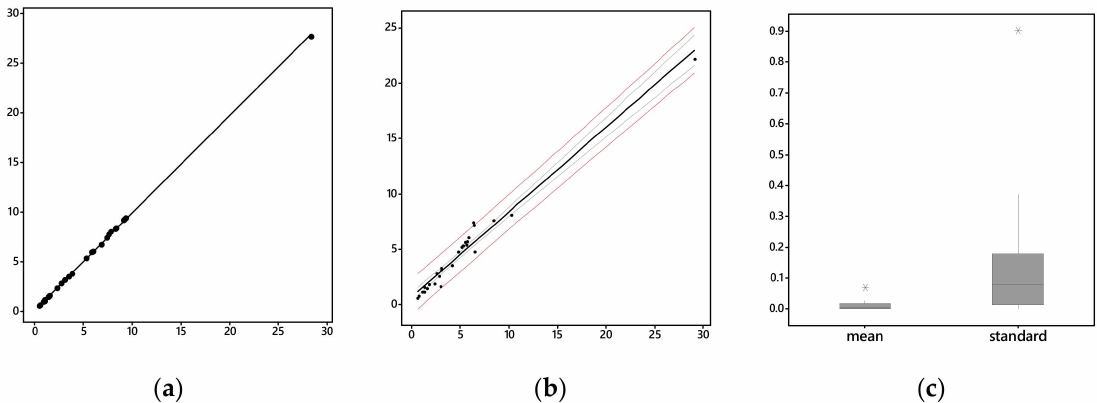
Figure A1. Quality assessment of Table A3 specimen back-transformations. Left ( a ): arithmetic means scatterplot; black line denotes the linear regression trend. Middle ( b ): standard deviation scatterplots; black line denotes the linear regression trend, the gray lines denote 95% confidence intervals, and the red lines denote 95% prediction intervals. Right ( c ): |observed—back-transformed|/observed box